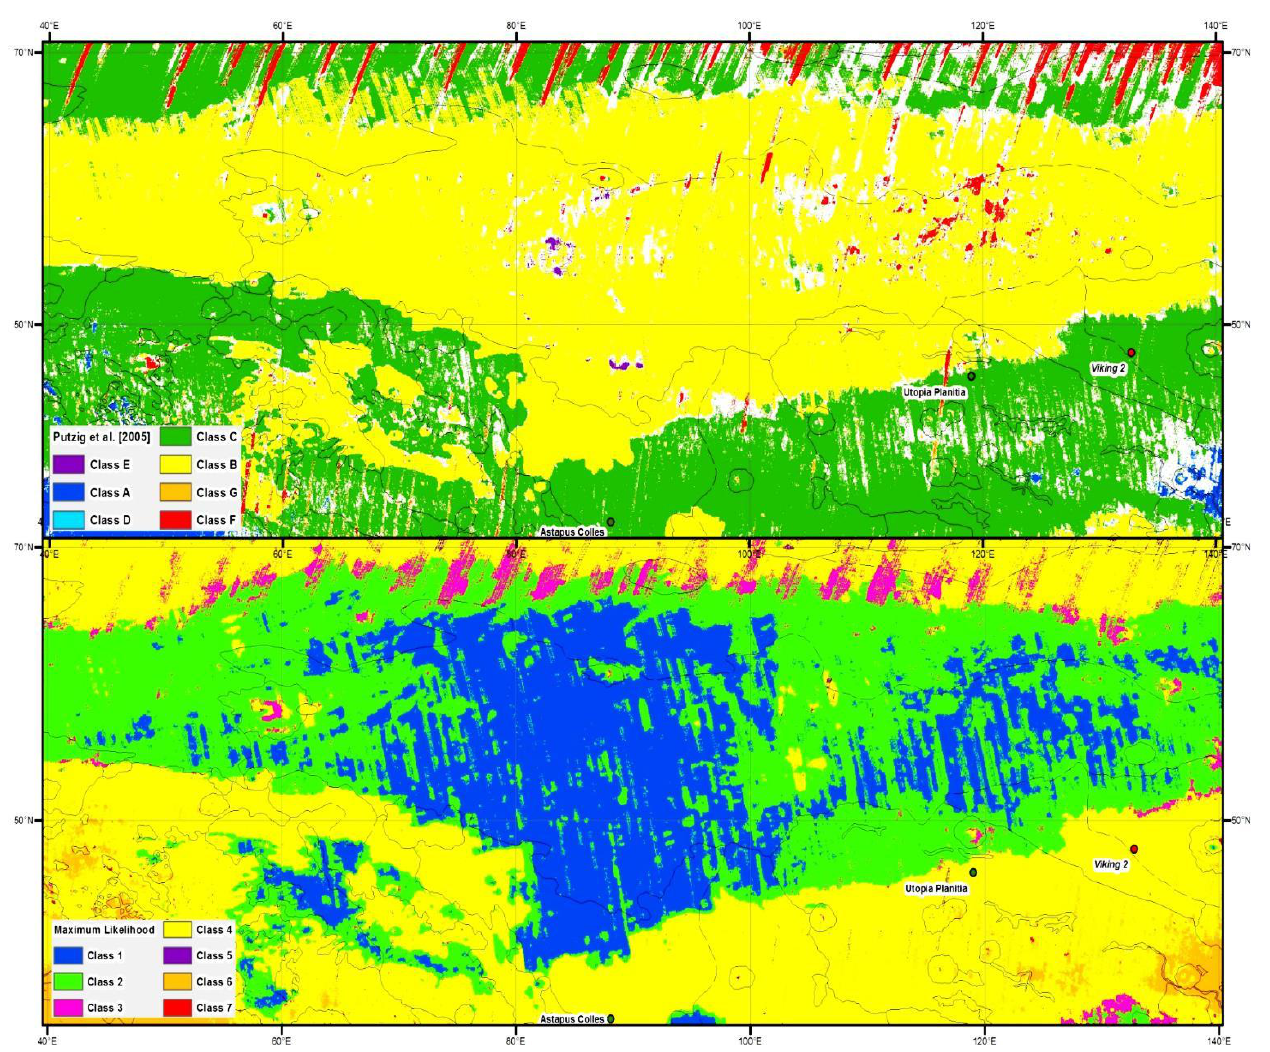
Figure 15. Comparison between the classification of Utopia Planitia in the thermophysical map of [8] ( top ) and the ISODATA + MAXLIKE classification of this work ( below ) using updated thermal inertia values. Black lines are the geologic contacts of